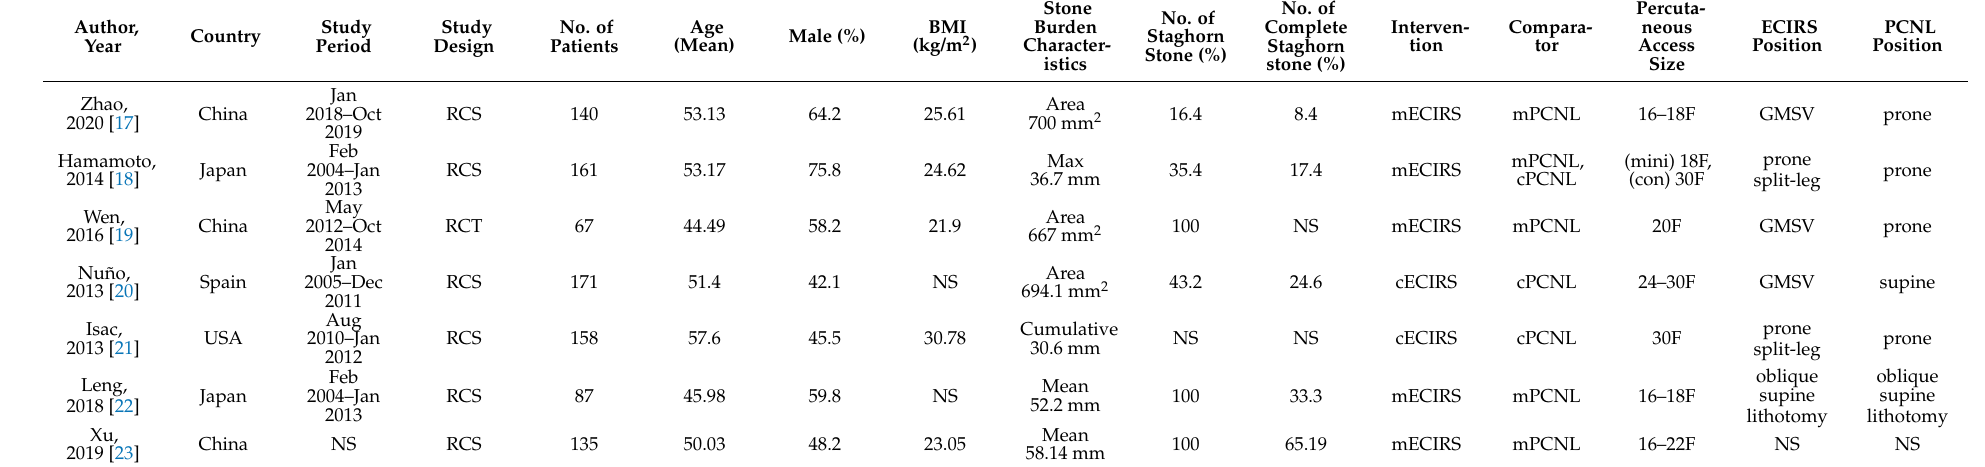
Table 1. Characteristics of included